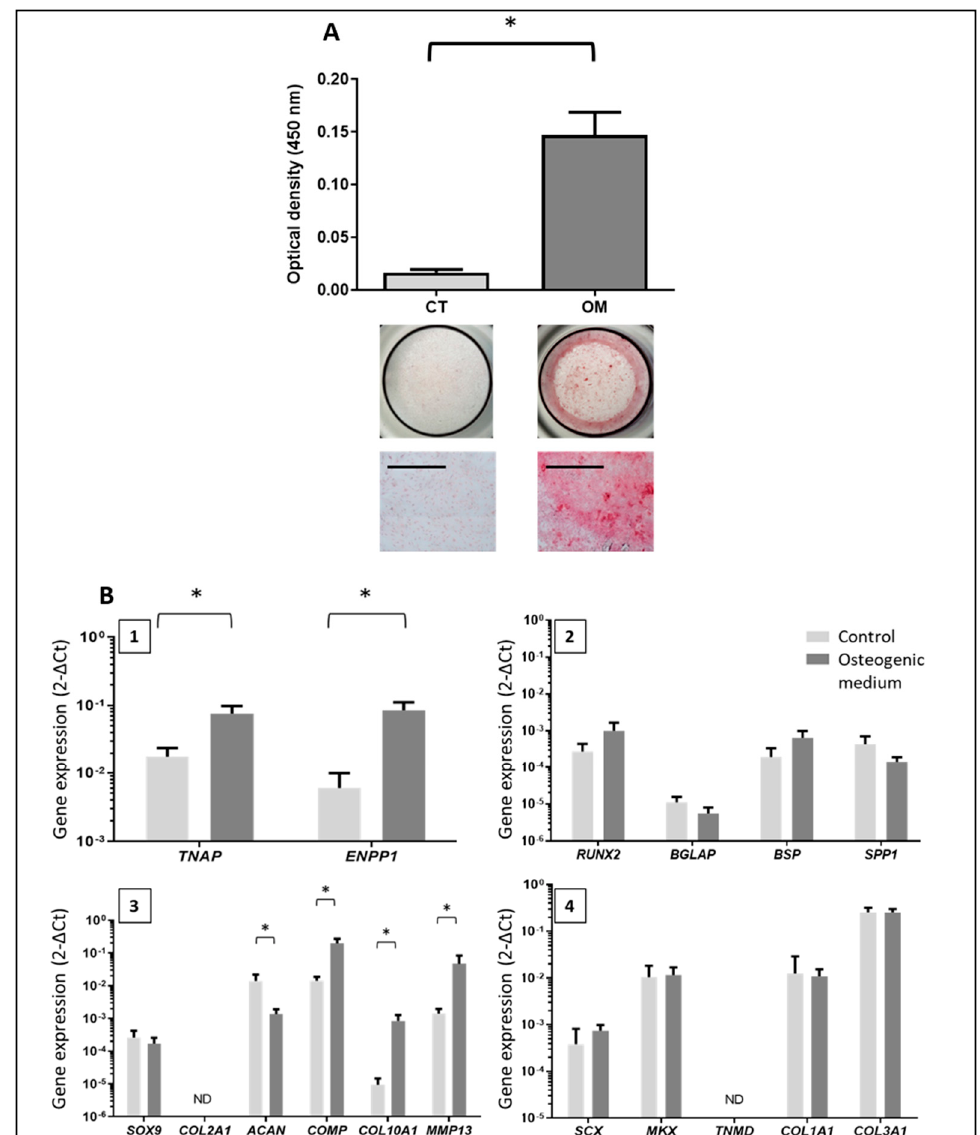
Figure 2. Assessment of mineral deposition induced by tenocyte-like cells (TLC) after 21 days in the osteogenic medium and characterization of mineralizing cells. ( A ) Assessment of mineral deposition by alizarin red S staining after 21 days ( N = 5). Quantification of the bound stain after solubilization with formic acid for the two conditions (reading at 450 nm) and representative images of the wells. CT: control medium; TLC: tenocyte-like cells; OM: osteogenic medium. Scale bar = 1 mm. ( B ) Gene expression by TLC cultured 21 days in the osteogenic medium or in the